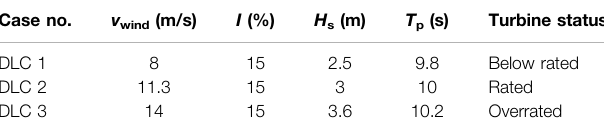
TABLE 3 | Design load cases (DLCs) for typical operational environmental condition